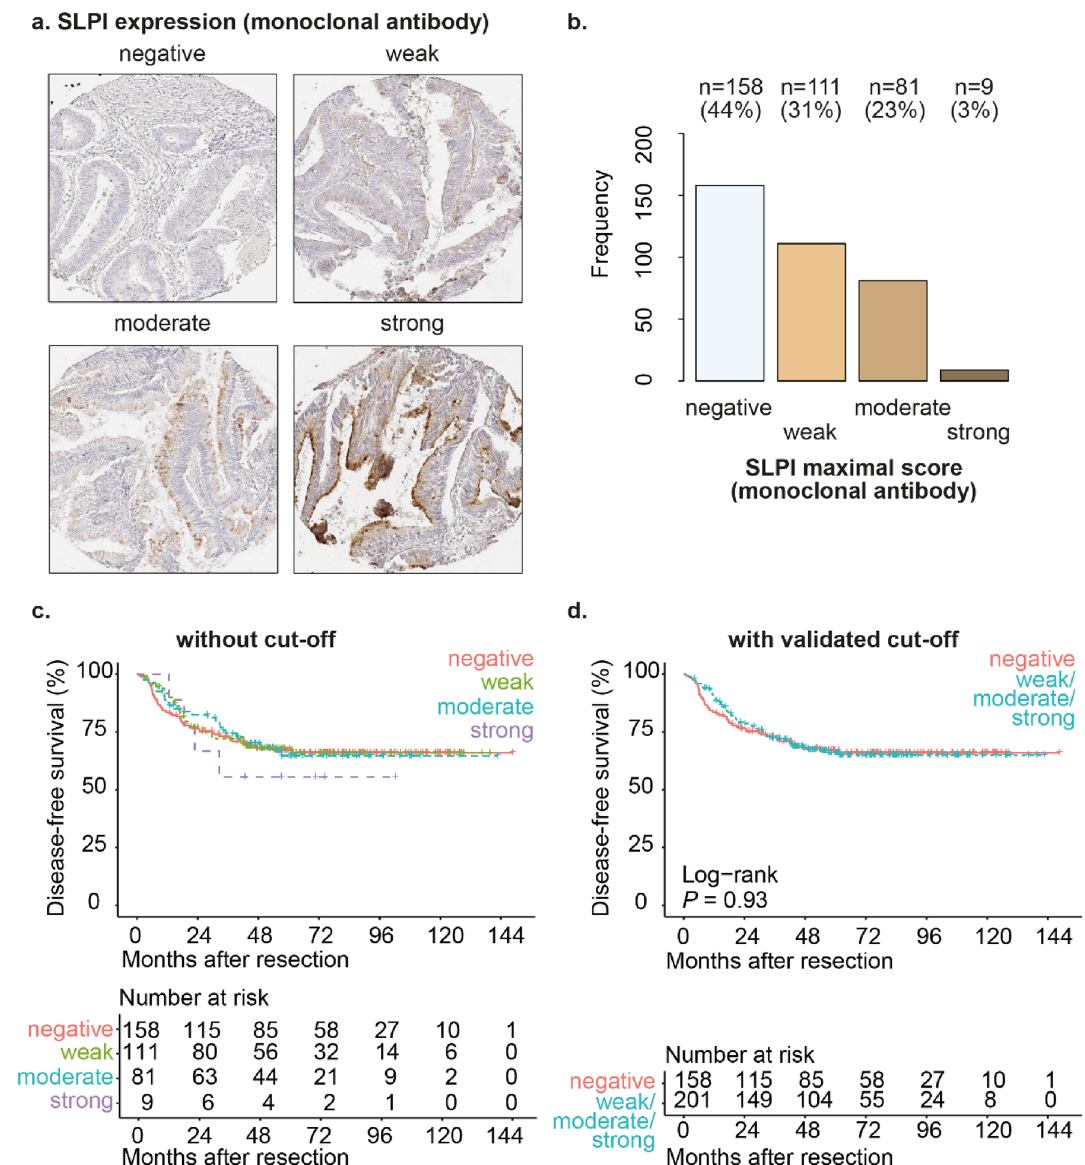
Figure 1. SLPI is expressed in a subset of stage II and stage III CRC. Examples of TMA cores of stage II or stage III CRC stained for SLPI using the monoclonal antibody ( a ). Frequencies and percentages of stage II or stage III CRC scored as ‘negative’, ‘weak’, ‘moderate’ or ‘strong’ after staining with the monoclonal SLPI antibody ( b ); only the maximum score for each patient was included. Kaplan–Meier curves for disease-free survival after resection of the primary tumor (in months) for the total study population of stage II and stage III CRC patients stratified by SLPI expression detected using the monoclonal antibody ( c , d ). Curves without a cut-off ( c ) and with the validated cut-off ( d ) are shown. P -values were calculated using the log-rank